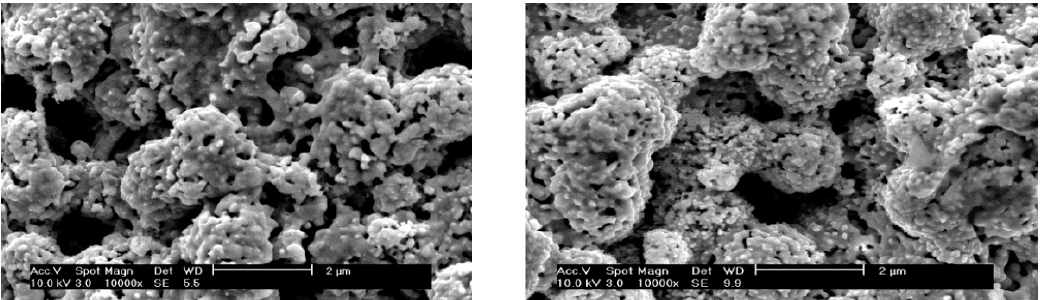
Figure A6. SEM images of high magnification of the inside surface of the wall ( left ) and outside surface of the wall ( Right ) of copper hollow fibers after calcination at 600 °C for 3 h and reduction at 280 °C for 1 h, respectively. Such fibers show the highest Faradaic Efficiency in reduction of CO 2 towards CO. Catalysts 2021 , 11 , x FOR PEER REVIEW